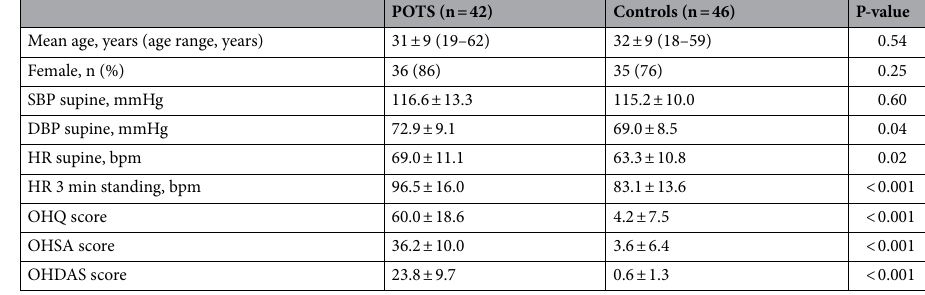
Table 1. Baseline characteristics and intergroup comparison between POTS and healthy controls. DBP: diastolic blood pressure; HR: heart rate; OHDAS: orthostatic hypotension daily activities; OHQ: Orthostatic Hypotension Questionnaire composite score; OHSA: Orthostatic Hypotension Symptom Assessment; POTS: postural orthostatic tachycardia syndrome; SBP: systolic blood pressure.